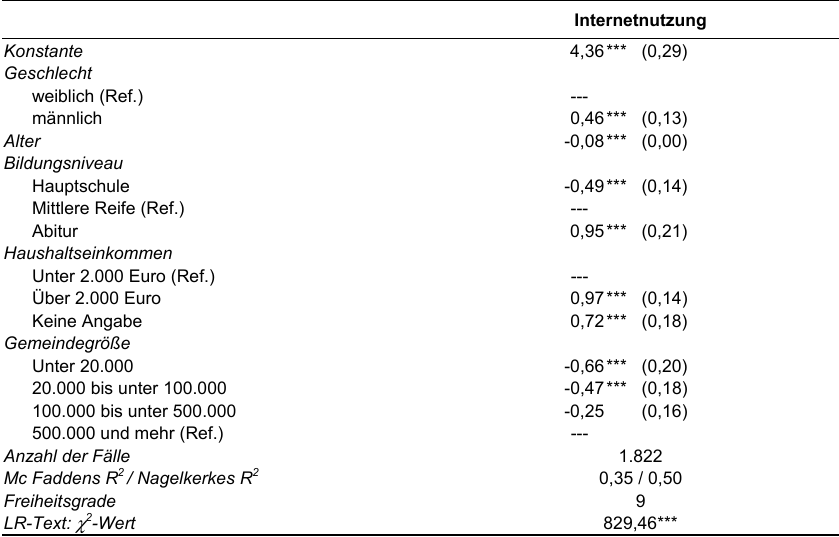
Tabelle 2: Logistische Regression der Determinanten der Internetnutzung (Regressionskoeffizienten, Standardfehler)